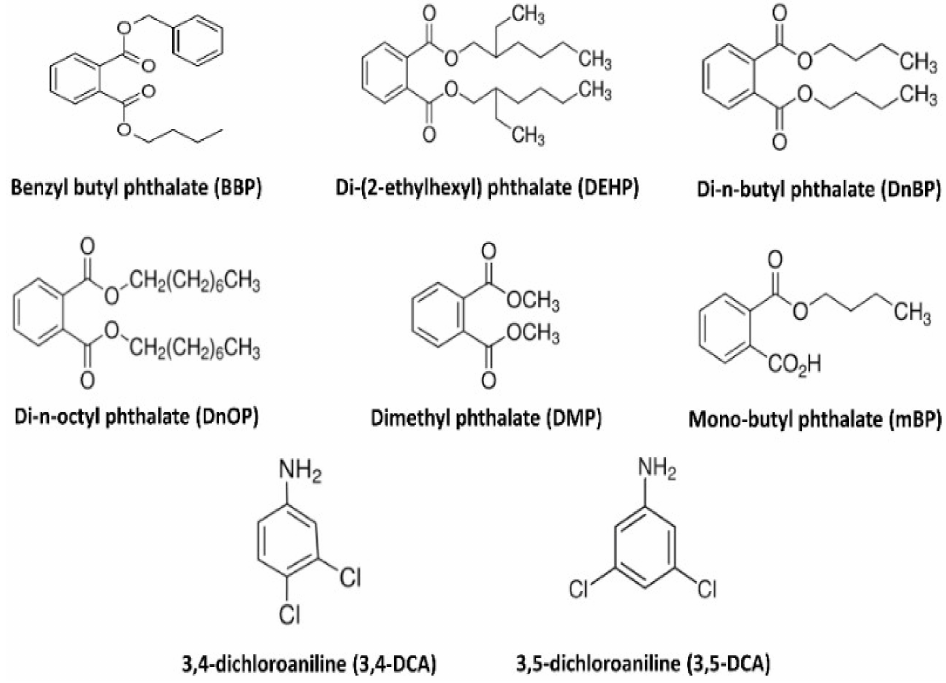
Figure 1. Chemical structures of the studied food